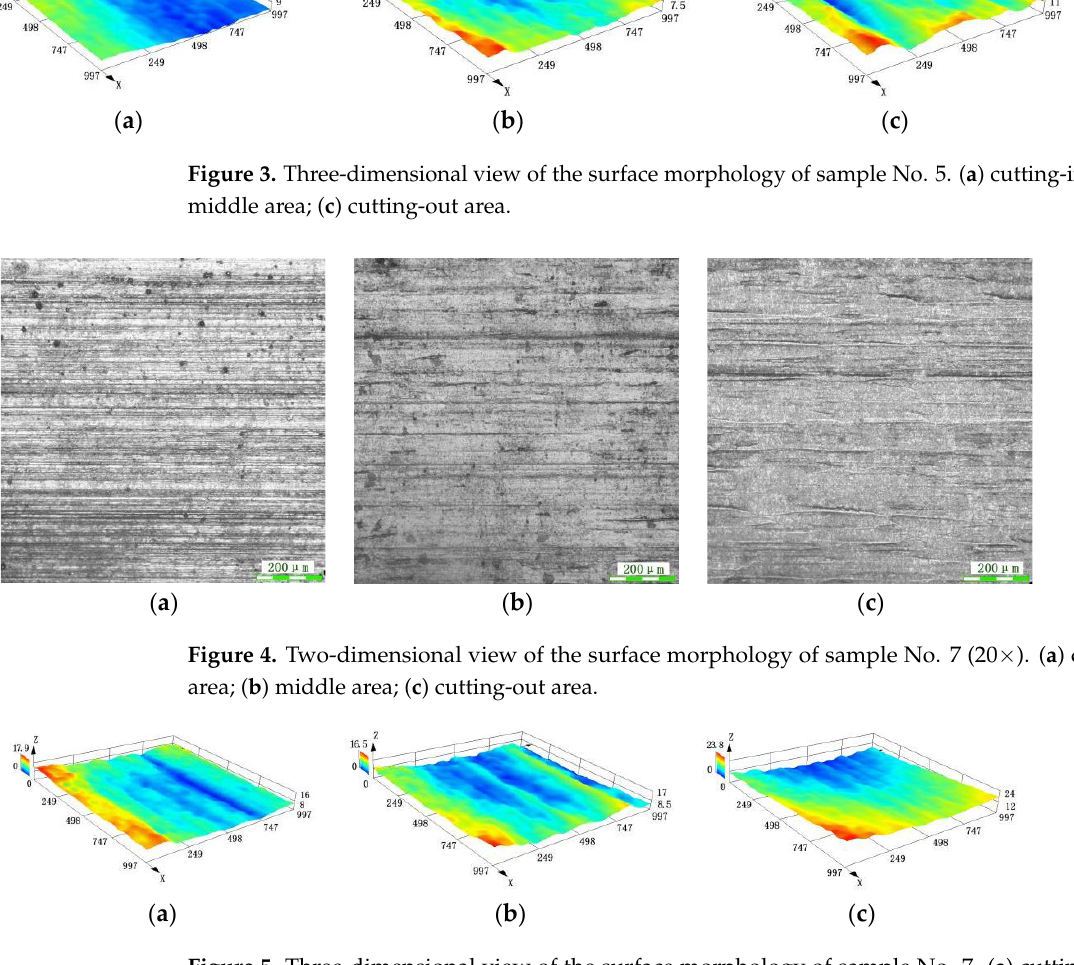
Figure 5. Three-dimensional view of the surface morphology of sample No. 7. ( a ) cutting-in area; ( b ) middle area; ( c ) cutting-out area.